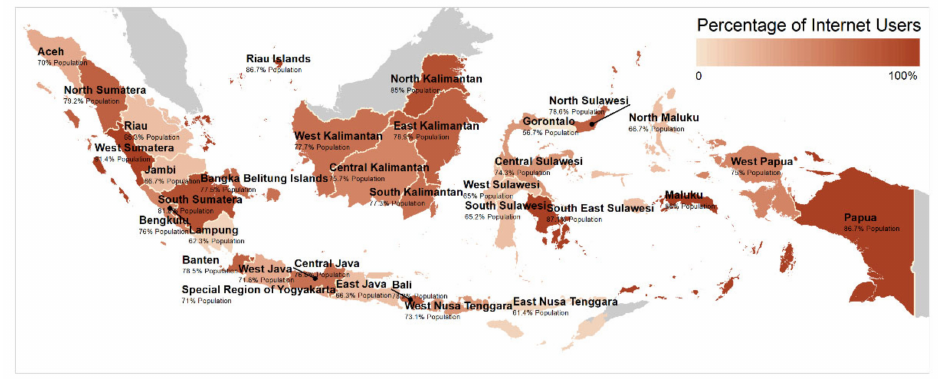
Figure 8. Distribution map of internet users as per total population in Indonesia in 2020. Source: [71].